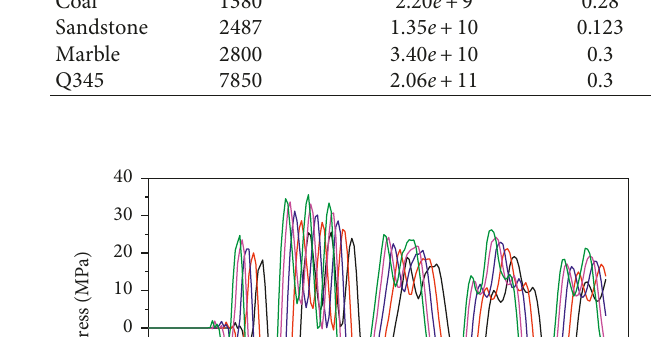
Figure 15: Different impact positions.